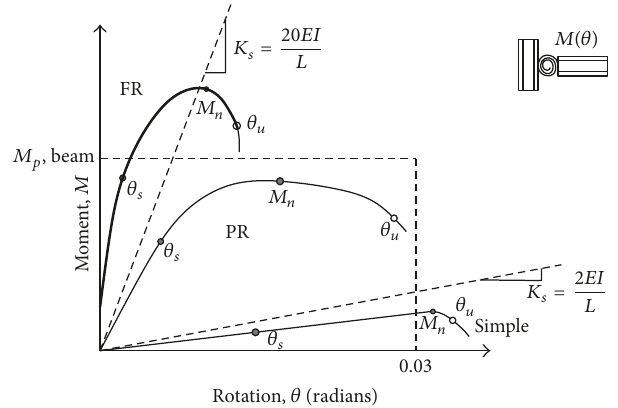
Figure 1: Moment-rotation curves for connections